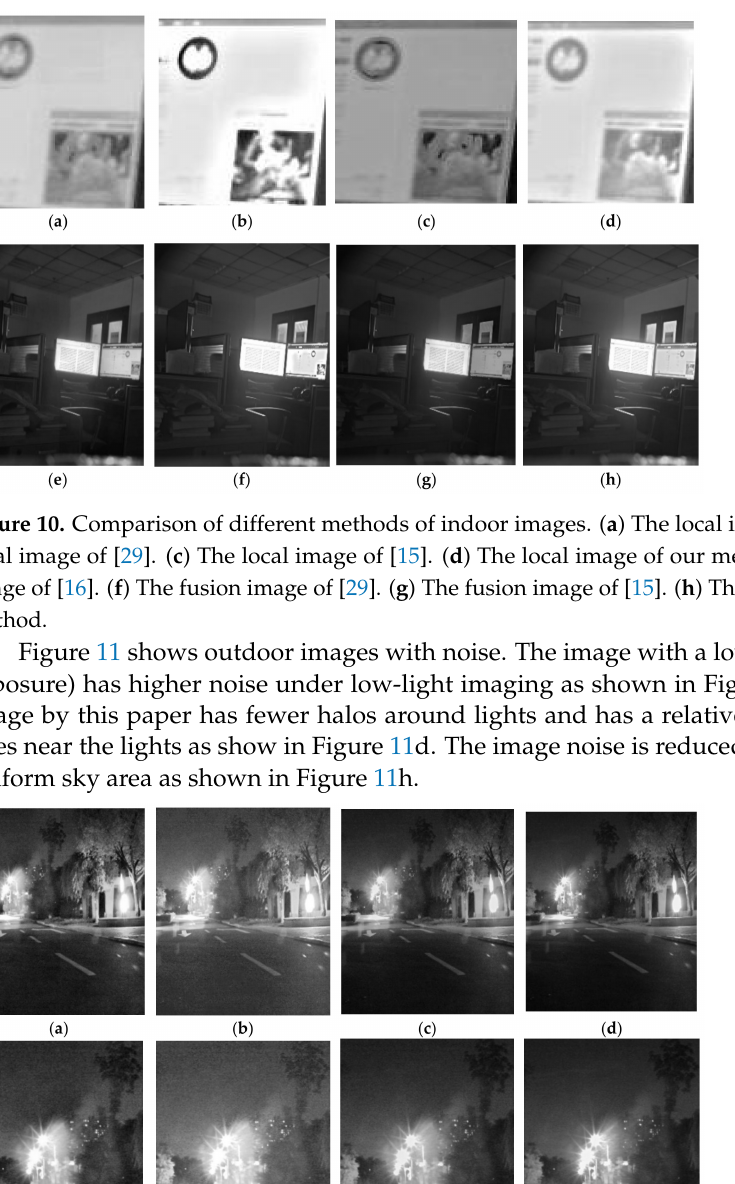
Figure 9. Source images of Figures 10 and 11. ( a ) Source images of Figure 10. ( b ) Source images of Figure 10. ( c ) Source images of Figure 11. ( d ) Source images of Figure 11.